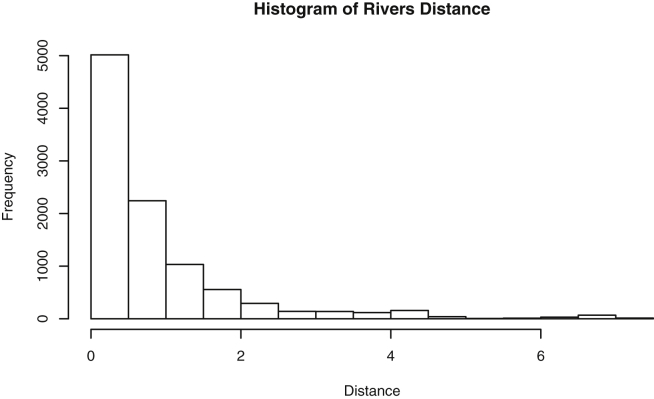
Rivers: Distances.